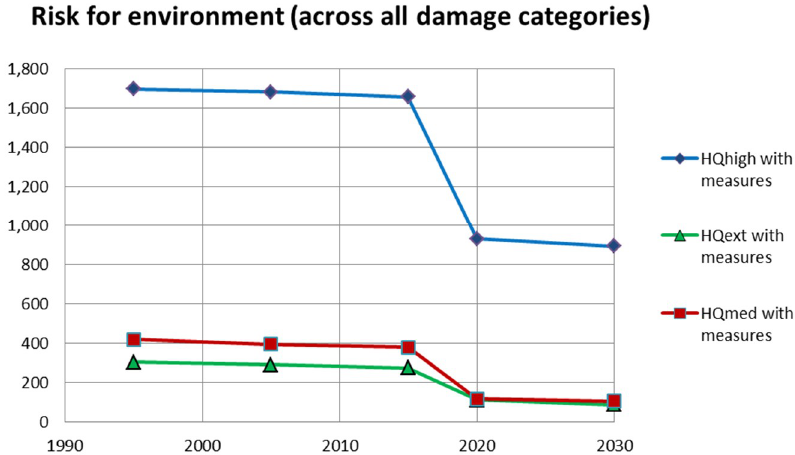
Figure 10. Risk evolution taking into account all measures (total damage index per year across all classes of damage) ( Y -axis) [8].